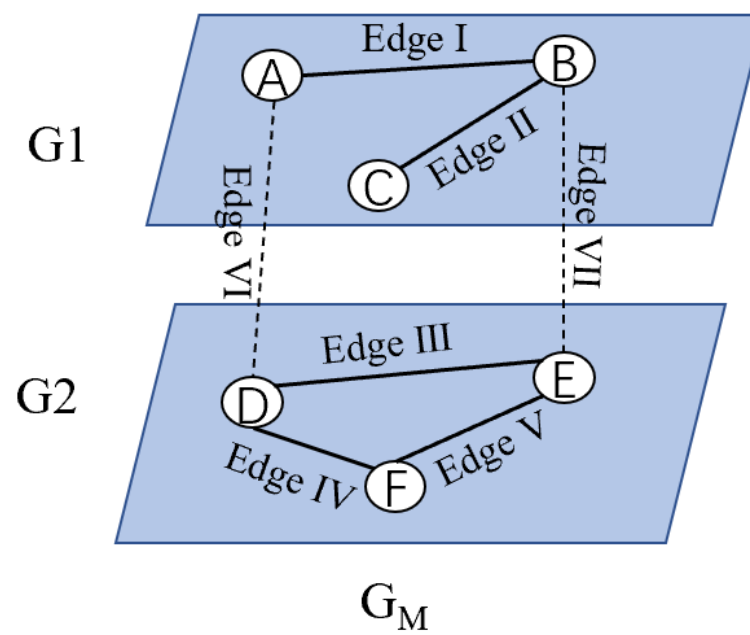
Figure 4. General multilayer network diagram.